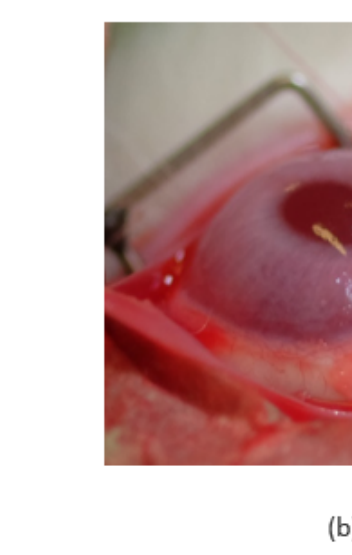
Figure 1. ( a ) Transconjunctival cryotherapy, ( b ) The appearance of the eye with the episclerally fixed implant before conjunctival closure.